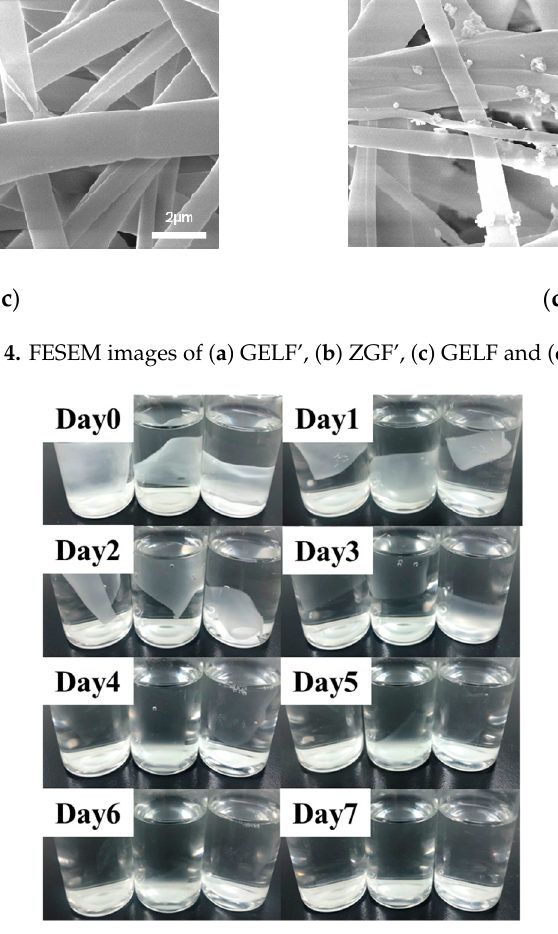
Figure 5. The degradation process of ZGF in phosphate buffer solution (PBS) at 37 °C.